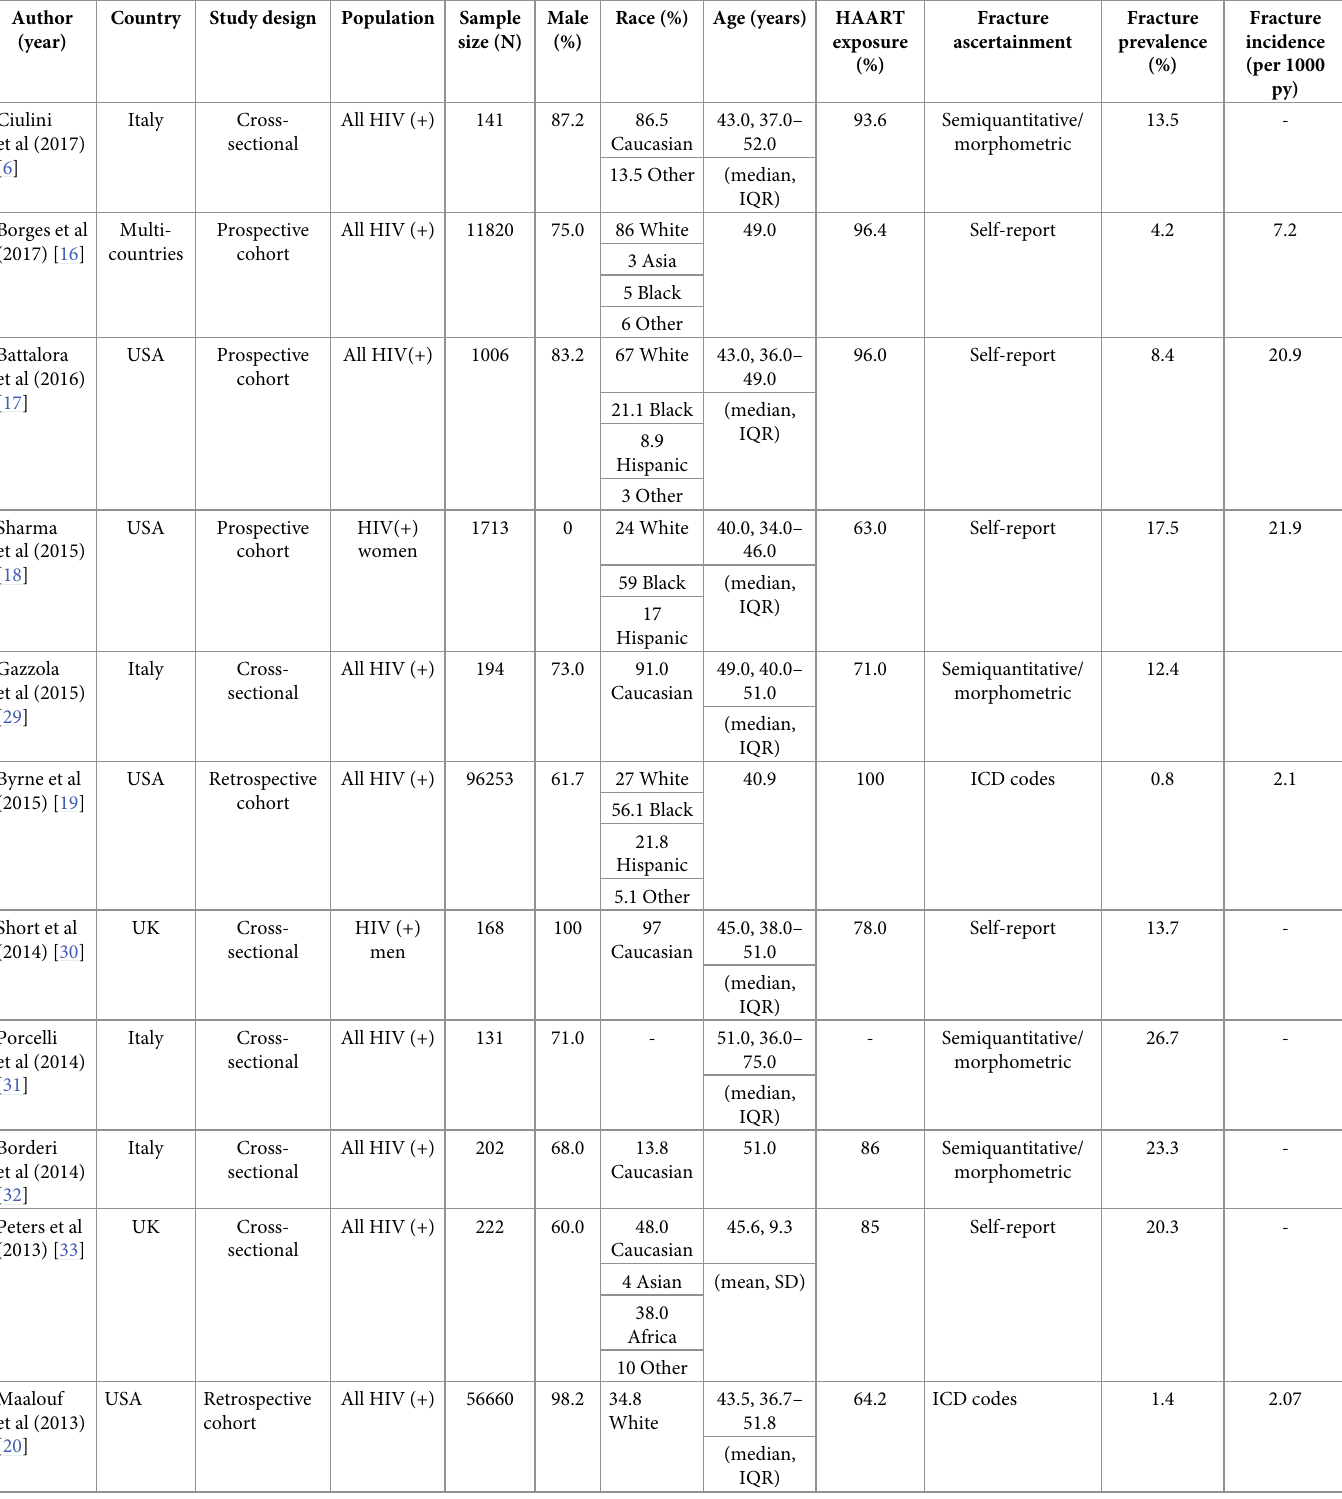
Table 1. Characteristic of studies reporting prevalence or incidence of bone fracture among PLWH (n =